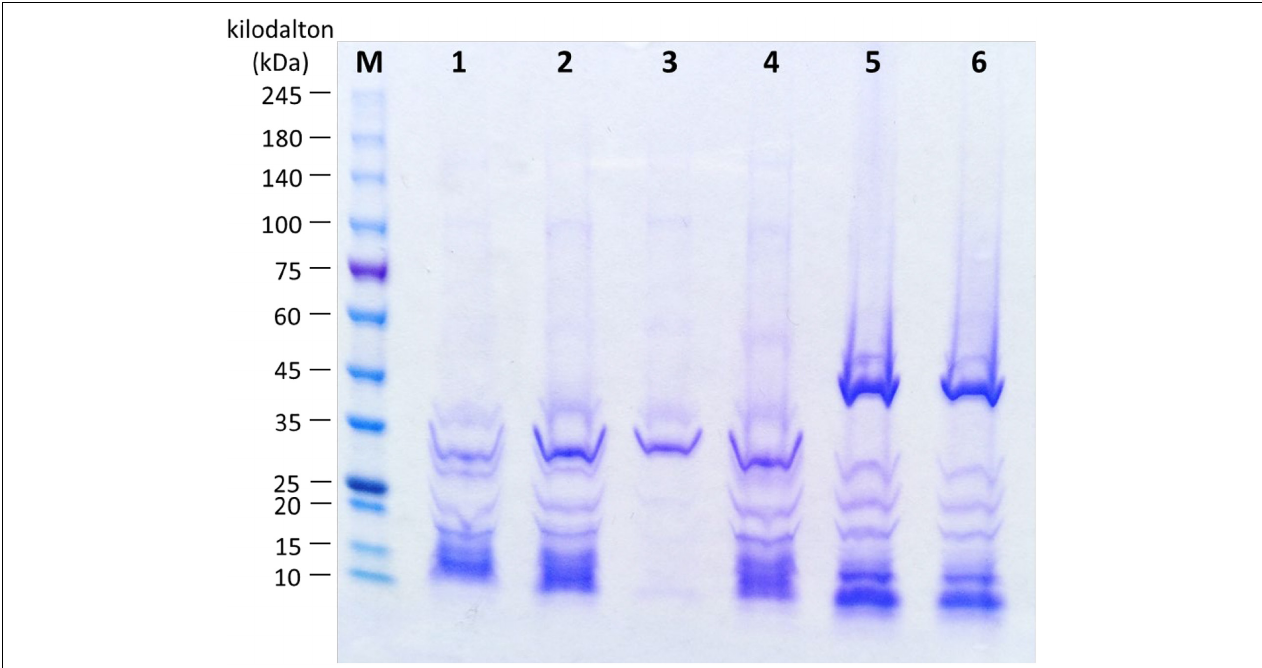
FIGURE 3 | Protein profiles of bacteriophages. Lane M: ExcelBandTM High Range Protein Marker, PM2610 (SMOBIO, Taiwan); Lane 1: Vp33; Lane 2: Vp22; Lane 3: Vp21; Lane 4: Vp02; Lane 5: Vp08; Lane 6: Vp11.